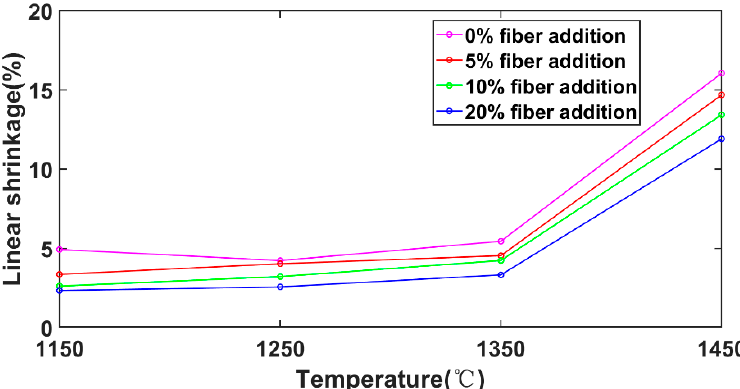
Figure 10. Linear shrinkage at different temperatures.